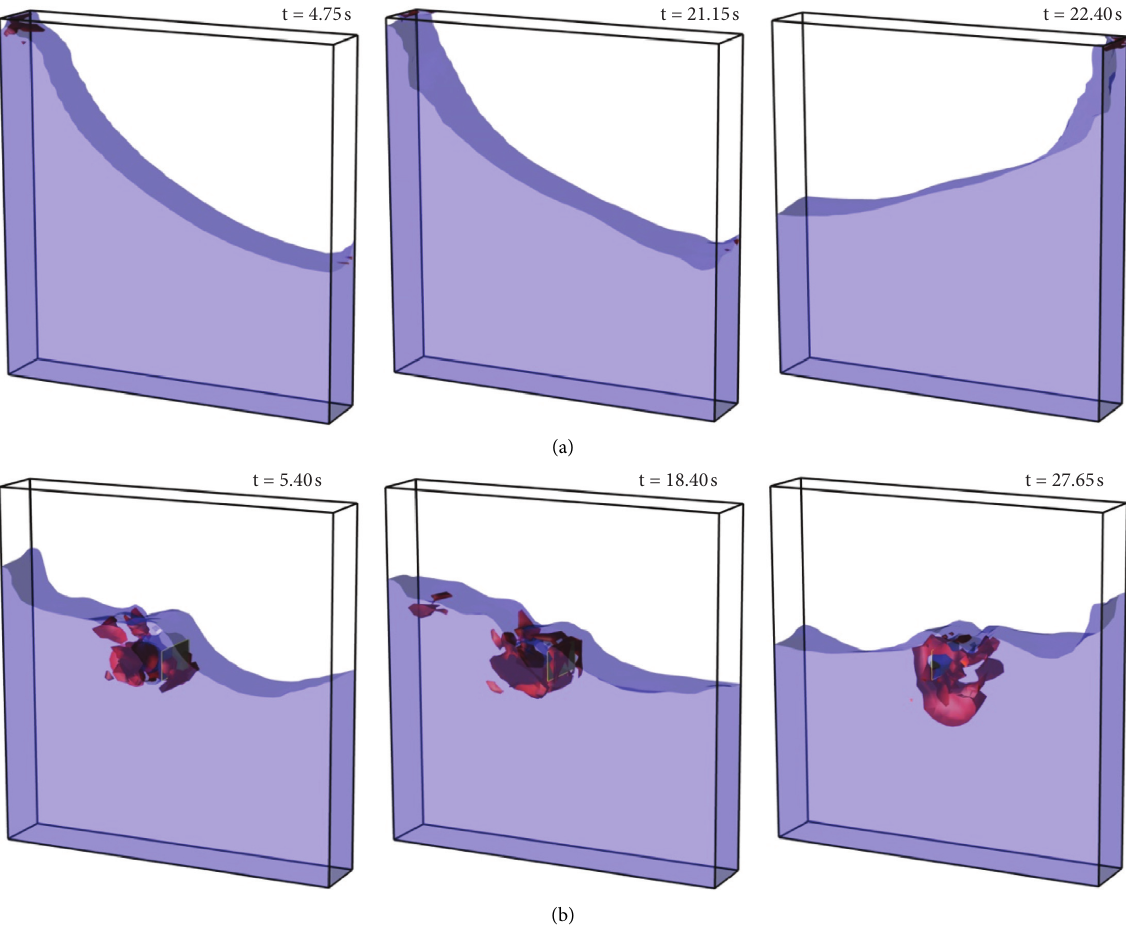
Figure 7: (a)Free surface snapshots and corresponding vortexes of coupled sloshing in the bare tank ( Dv / h � 0.0) and (b) tank with a vertical baffle at the mean water depth ( Dv / h �